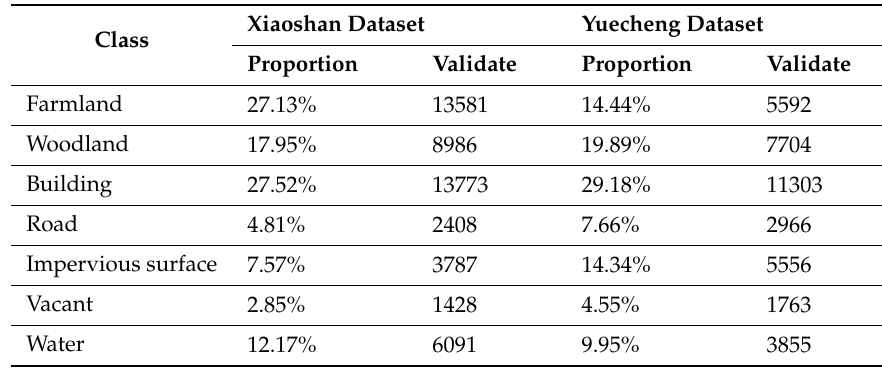
Table 7. Land-cover classes and sample numbers in Xiaoshan and Yuecheng validating